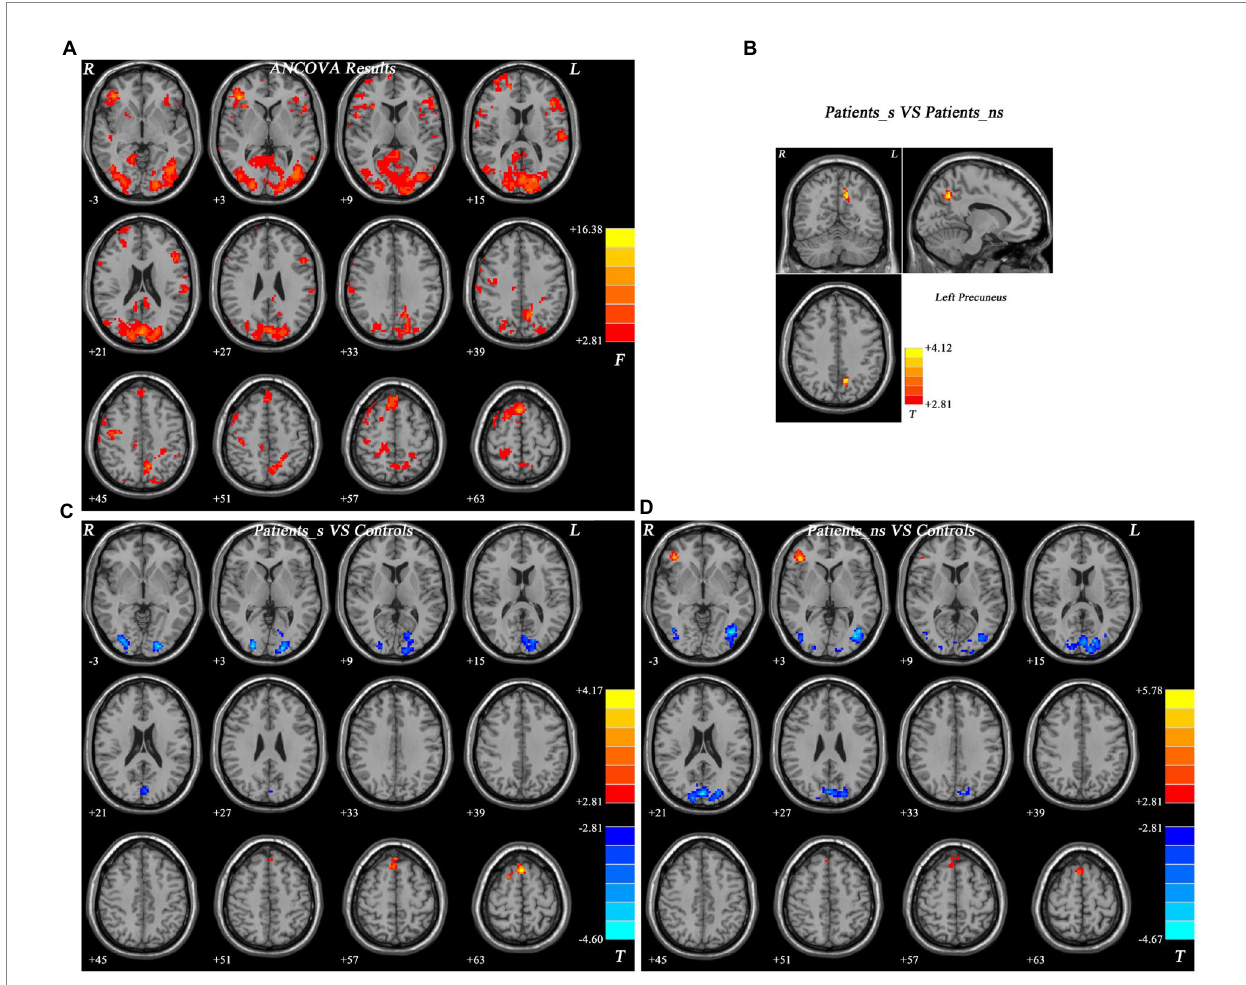
FIGURE 1 Different fALF F values and brain regions with significantly different fALFF values across three groups. The color bar indicates the F values based on ANCOVA (A) . Brain regions with fALFF difference between Pa_s and Pa_ns (B) . Brain regions with fALFF difference between Pa_s and HCs (C) . Brain regions with fALFF difference between Pa_ns and HCs (D) . For panels (B–D) , the color bar indicates the t values from post-hoc t -tests. Red and blue colors, respectively, represent increased and decreased fALFF. fALFF, fractional amplitude of low-frequency fluctuation; ANCOVA, analysis of covariance. Pa_s , major depressive disorder with sleep disturbance; Pa_ns , major depressive disorder without sleep disturbance. HCs, healthy